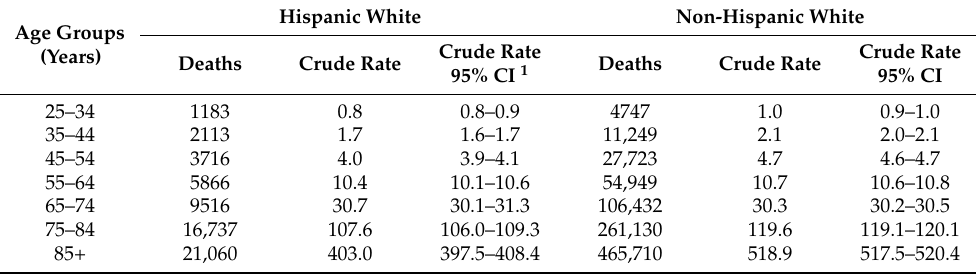
Table 1. Influenza and pneumonia deaths and crude mortality rate per 100,000 by age group for Hispanic whites and non-Hispanic whites, United States: 1999 to 2018.